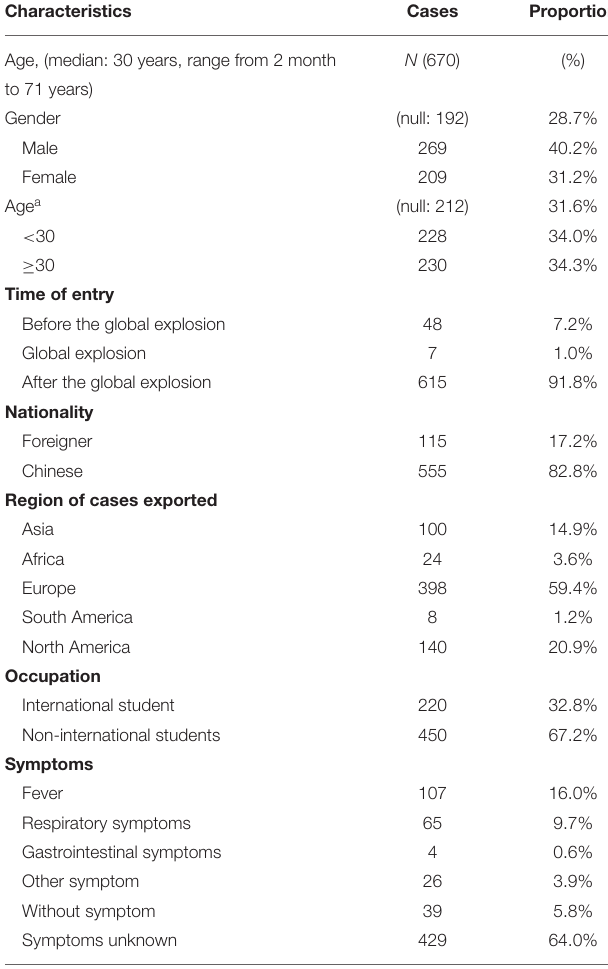
TABLE 1 | Clinical characteristics of imported patients of